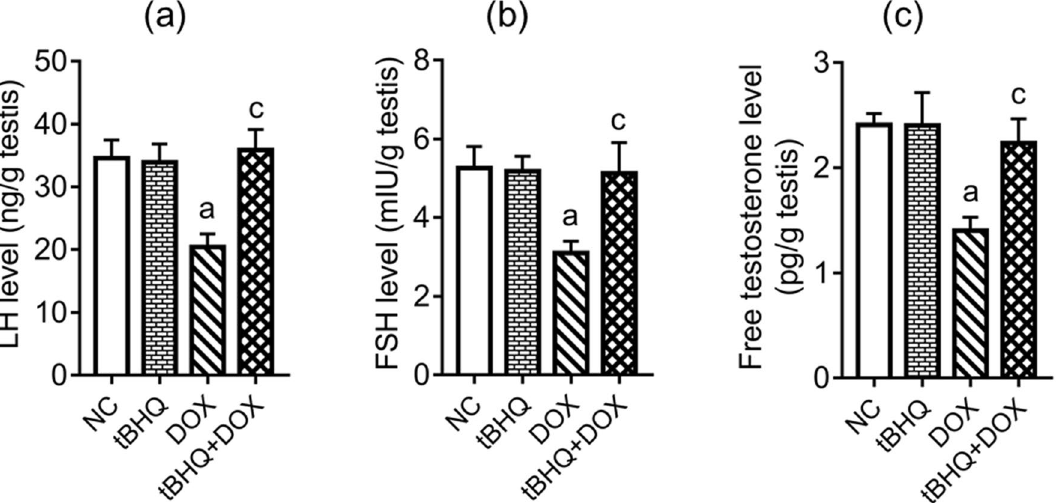
Figure 2. Effect of tBHQ on testicular levels of LH ( a ), FSH ( b ) and free testosterone ( c ) in DOX- treated rats. NC: normal control, tBHQ: tert-butylhydroquinone, DOX: doxorubicin, tBHQ + DOX: tert- butylhydroquinone + doxorubicin, FSH: follicle stimulating hormone, LH: luteinizing hormone. Values are mean ± SD, n = 6/group. a p < 0.05 versus NC; c p < 0.05 versus DOX (One-way ANOVA with Tukey’s post-hoc